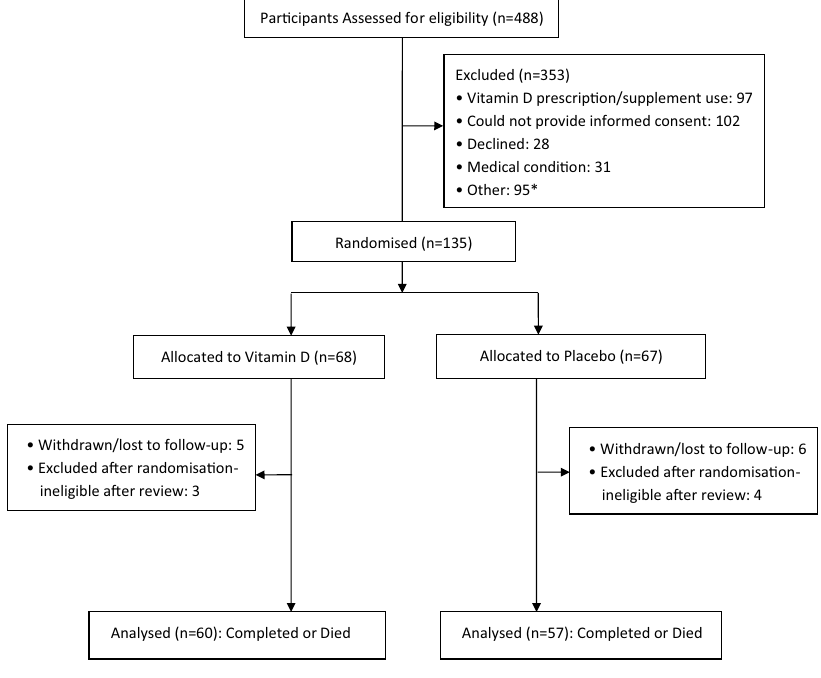
Figure 1. Participant Flow. * The predominant ‘Other’ reasons participants were excluded from the study were: use of immunosuppressants, previous history of nephrolithiasis and